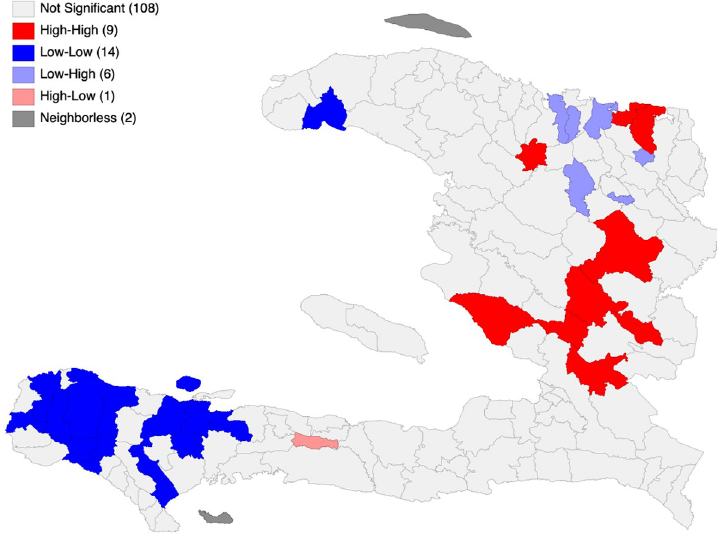
Fig 3. LISA map of average diphtheria incidence (per 100,000), Haiti, December 2014 –June 2021.